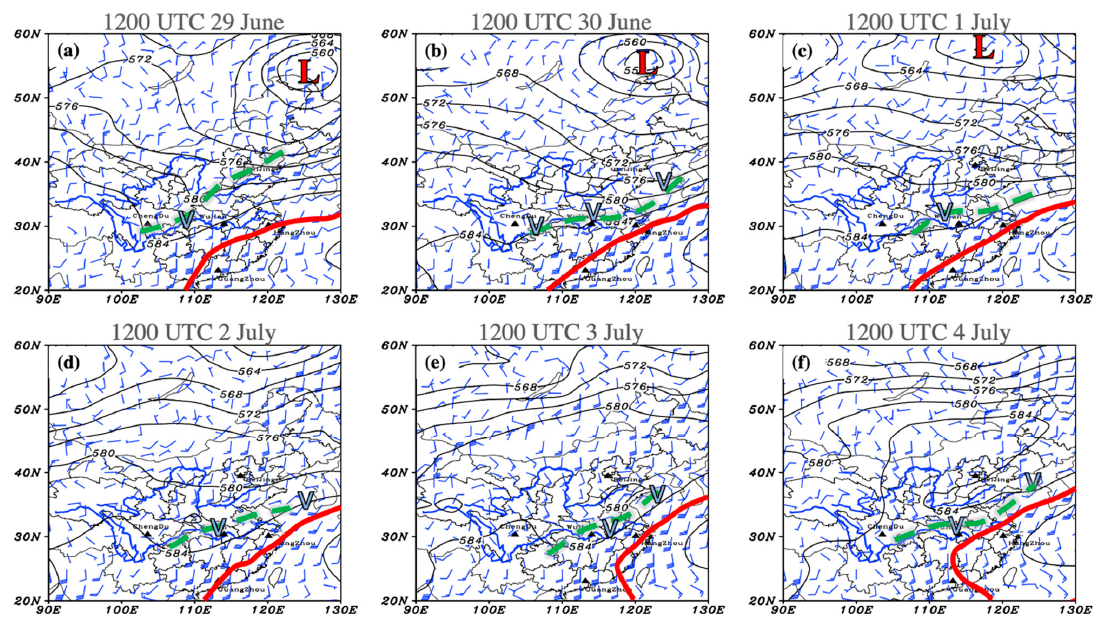
Figure 3. European Centre for Medium-Range Forecasts (ECMWF) 0000-h forecast valid at ( a ) 1200 UTC 29 June, ( b ) 1200 UTC 30 June, ( c ) 1200 UTC 1 July, ( d ) 1200 UTC 2 July, ( e ) 1200 UTC 3 July, and ( f ) 1200 UTC 4 July, 2016. Plotted are the 500 hPa geopotential heights (decameters, medium black contour, 4 dam contour interval) and the 850 hPa wind vectors (knots, blue barbs, typical meteorological conventions). The Meiyu front is objectively identified as the area of maximized horizontal shear at 850 hPa (green dashed lines). Objectively identified embedded closed mesoscale vortices along the front are denoted with a ‘V’, and the 588 dam contour is denoted by the thick red contour. Thin black contours denote political boundaries and thick blue lines denote the Huanghe and Yangtze Rivers to the north and south, respectively.